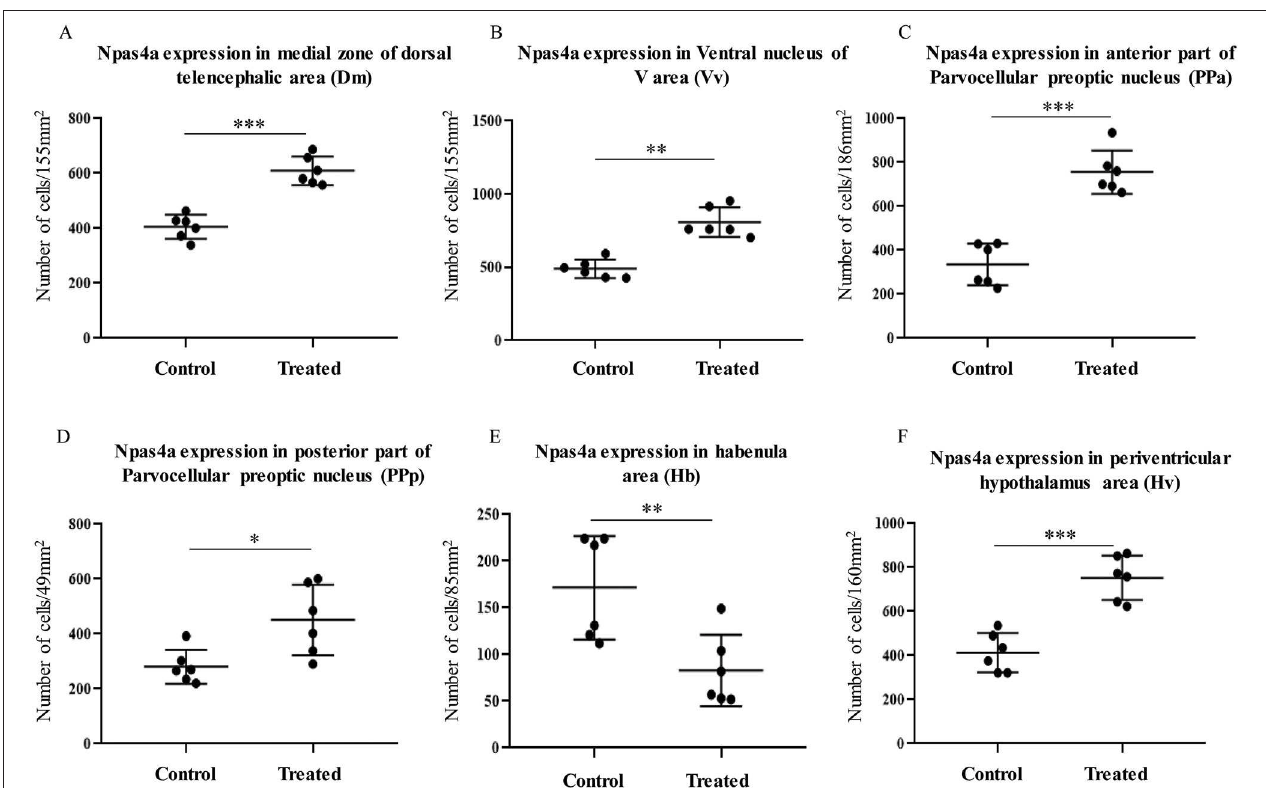
FIGURE 6 | Number of npas4 mRNA expressing cells in control and morphine-treated fish. (A–F) Graphs showing the difference in npas4a mRNA expression via cell counting after exposure to acute vehicle (control) and morphine via water immersion. (A) Medial zone of the dorsal telencephalic area, (B) ventral nucleus of the ventral telencephalic area, (C,D) anterior and posterior part of parvocellular preoptic area, (E) habenula, and (F) ventral periventricular hypothalamus. Data are presented as mean ± SEM. Independent t -test comparisons between control and morphine-treated fish. * P < 0.05; ** P < 0.01, *** P < 0.001 vs. controls ( n =